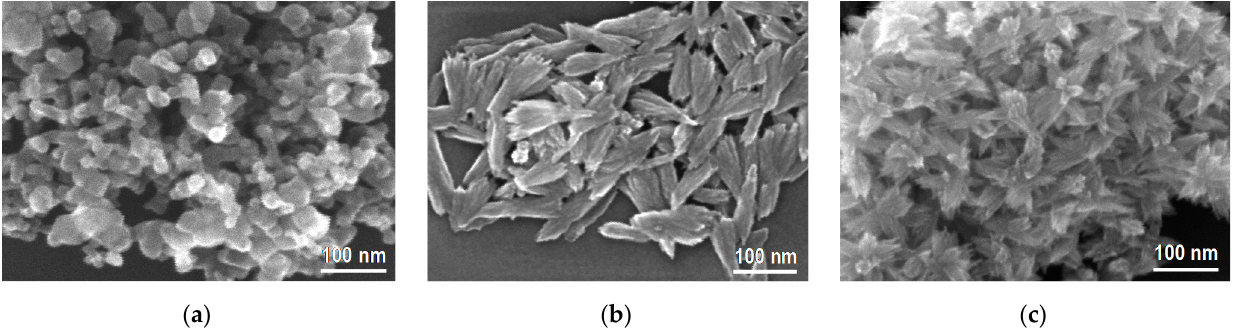
Figure 10. SEM images of ( a ) P25 standard; ( b ) TiO 2 obtained by sol–gel method; ( c ) TiO 2 obtained by inverse microemulsion method. Both ( b , c ) samples obtained from TiCl 4 precursor.